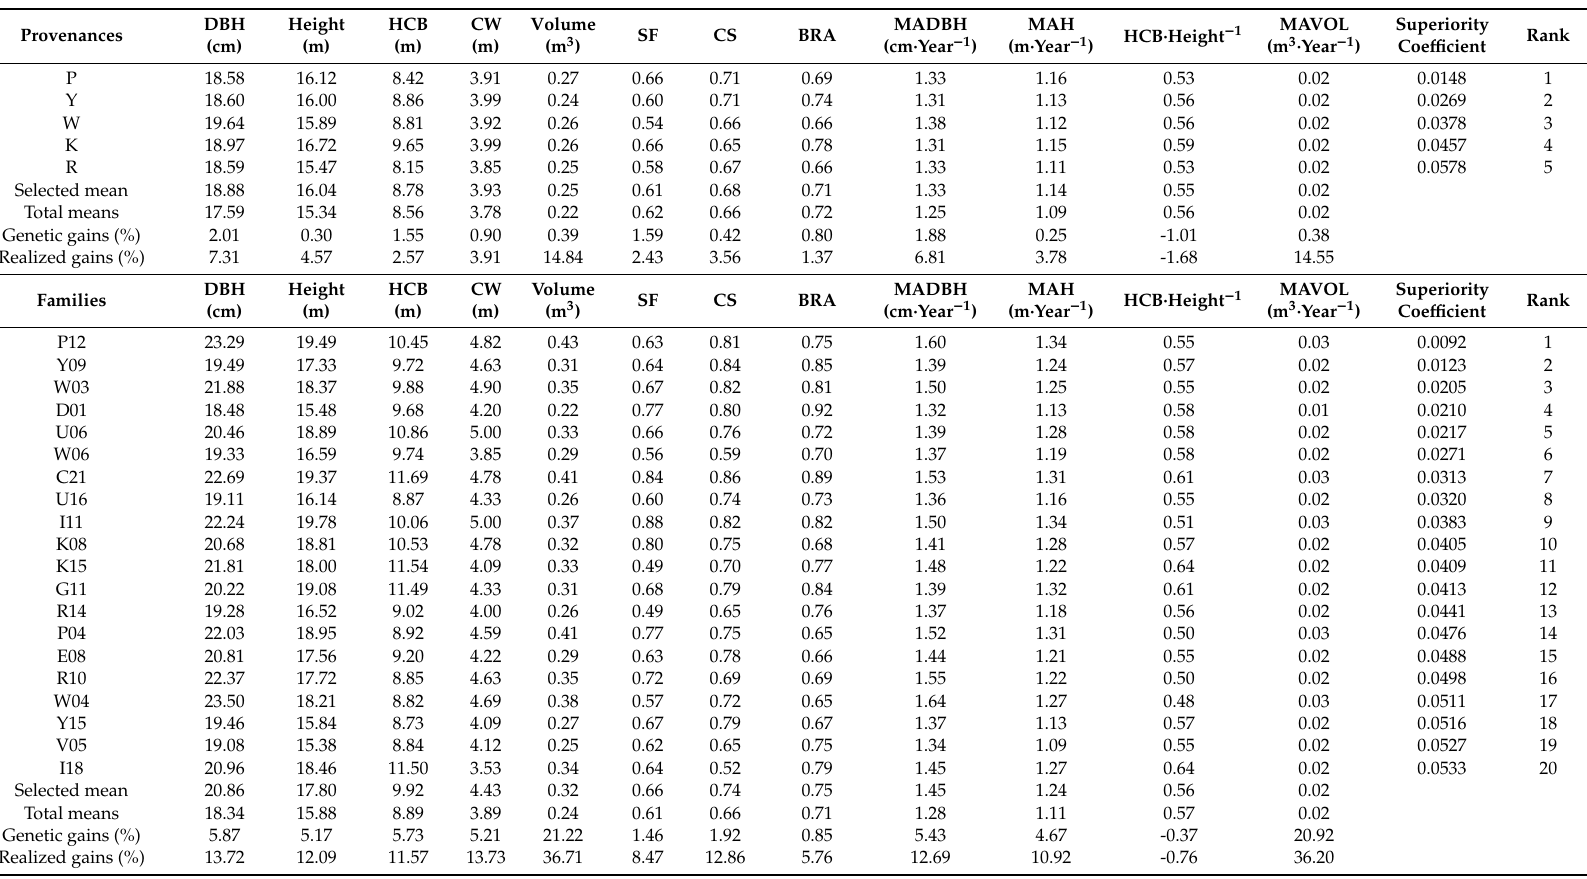
Table 8. Growth, quality traits and realized gains of the excellent provenances and